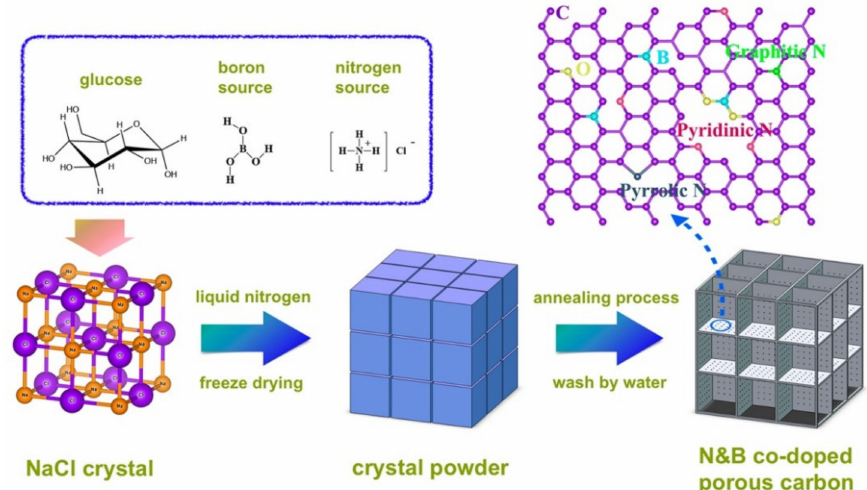
Figure 15. Schematic illustration of the synthesis of N and B co-doped porous carbon (NBPC) with a uniform 3D hierarchical structure. Adapted from